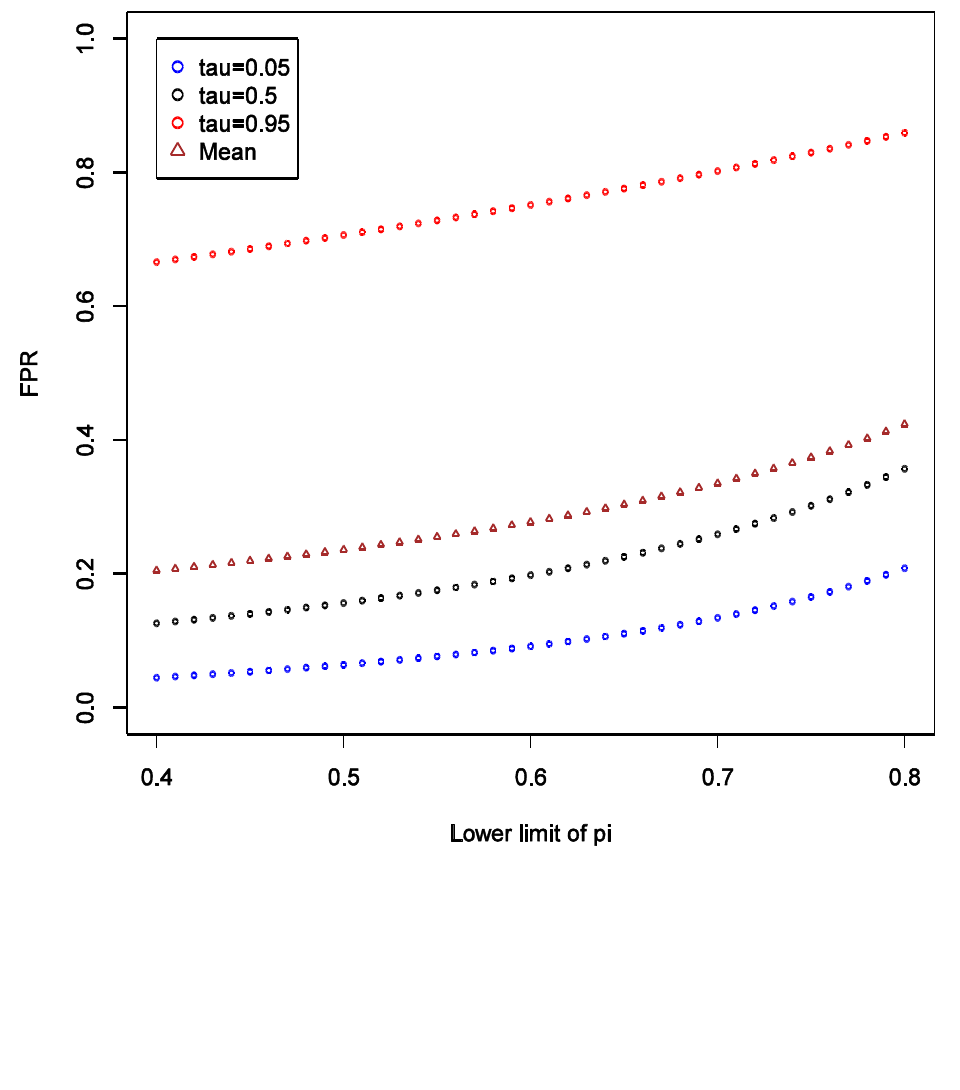
Figure 5. Theoretical calculations of the impact of varying strength belief in null hypothesis being true = pi (π); tau (τ) = expected quintiles of the distribution for false positive rate (FPR); see text for details of other parameter